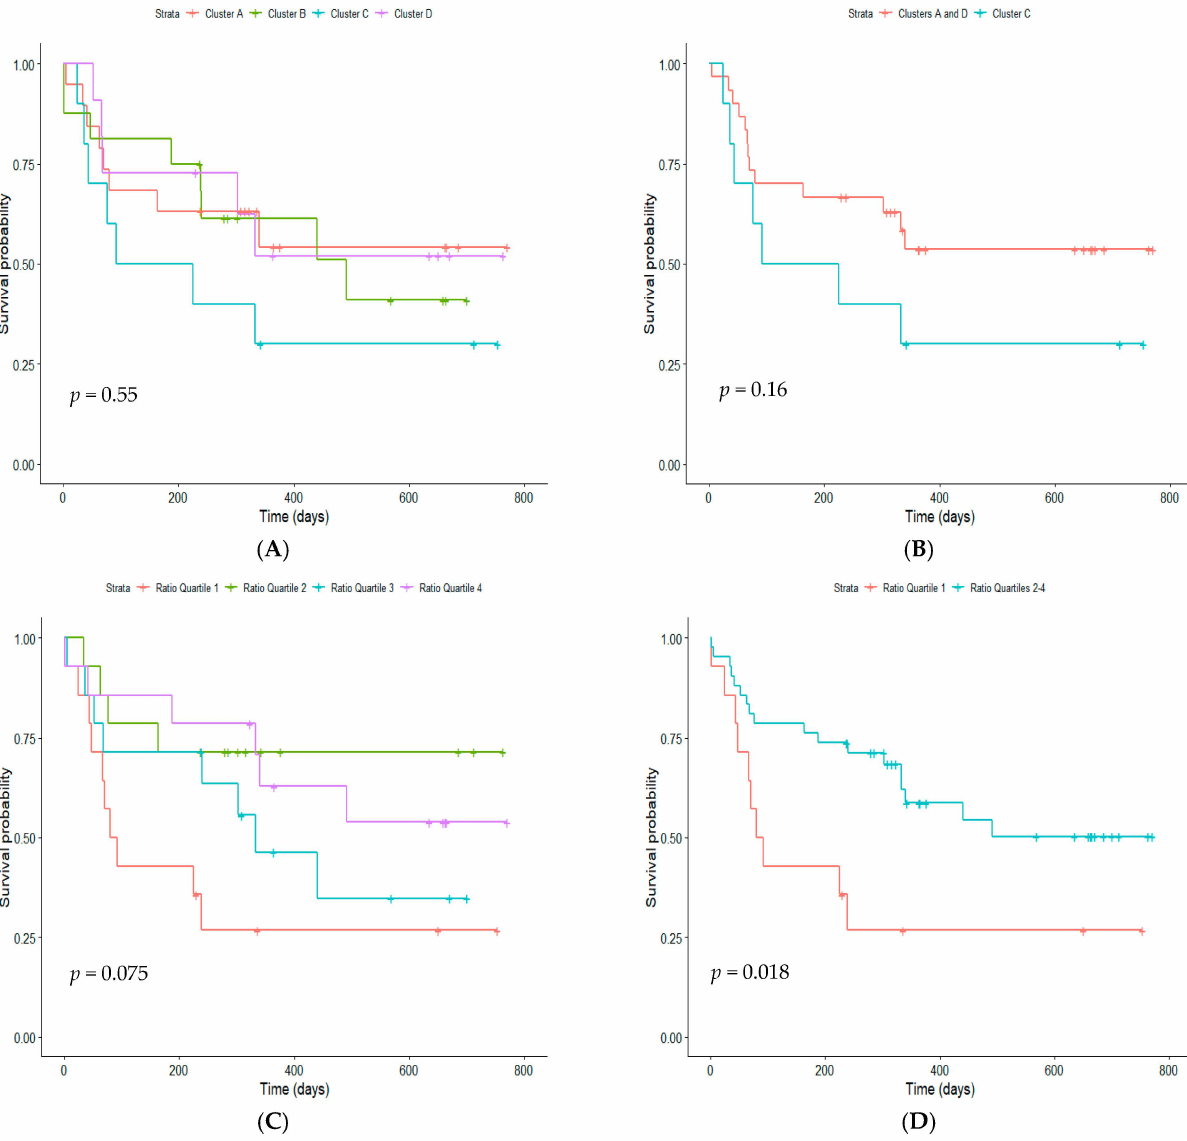
Figure 3. Survival curves of time (days) until next hospitalization for ( A ) Clusters A, B, C and D, ( B ) Clusters A and D combined and Cluster C, ( C ) IFN: FCER1G quartiles 1–4 and ( D ) IFN: FCER1G quartile 1 and quartiles 2–4